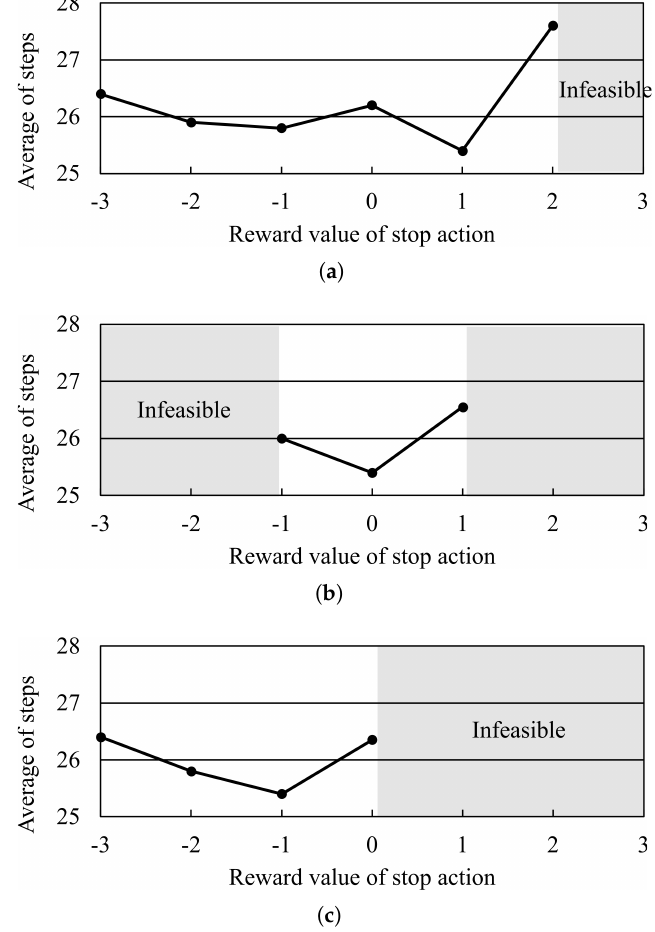
Figure 19. The impact of the parameter setting of the reward of Q–learning. a Reward value for A* path direction and non forward action; ( b ) Reward value for non A* path direction and non stop action; ( c ) Reward value for non A* path direction and stop